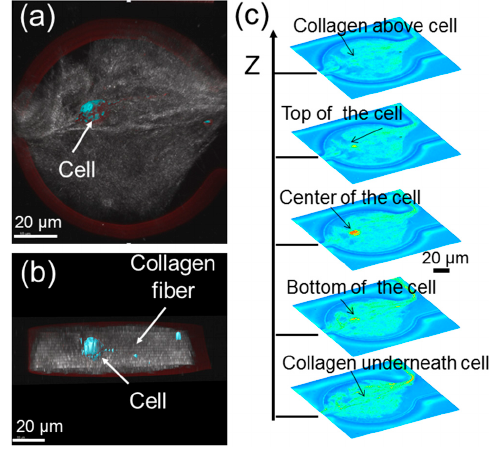
Figure 3. Confocal images showing one cell inside a 3D microtissue in a storage chamber: ( a ) topside view; ( b ) cross-section view; ( c ) stacked confocal images of a microtissue showing one cell inside a 3D